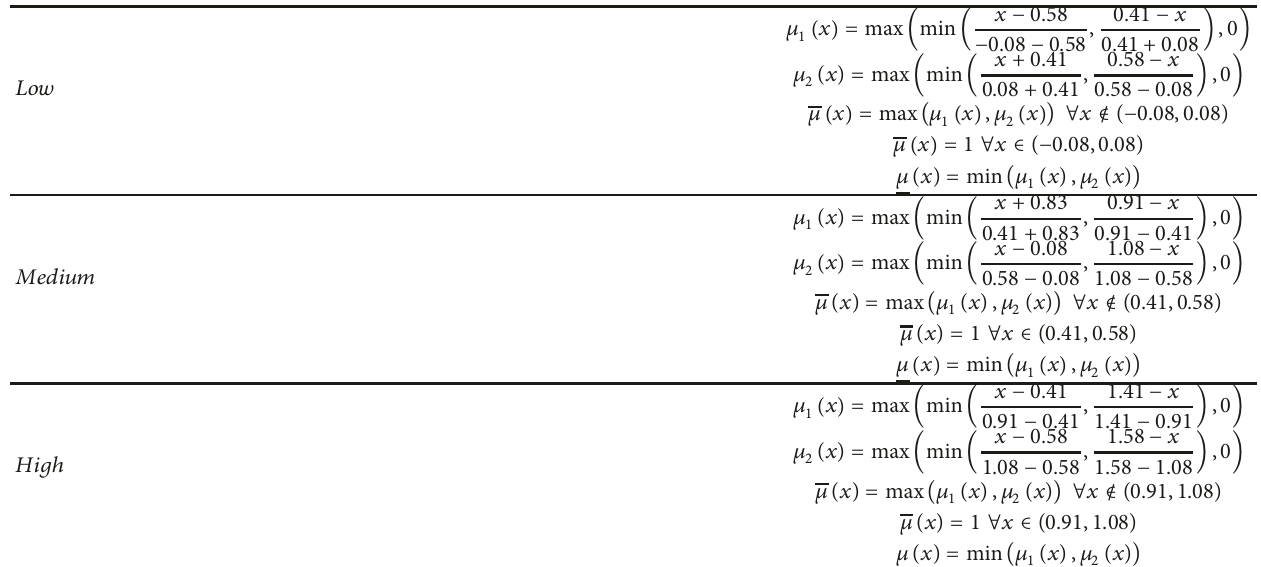
Table 2: Interval type-2 membership functions for the input and output